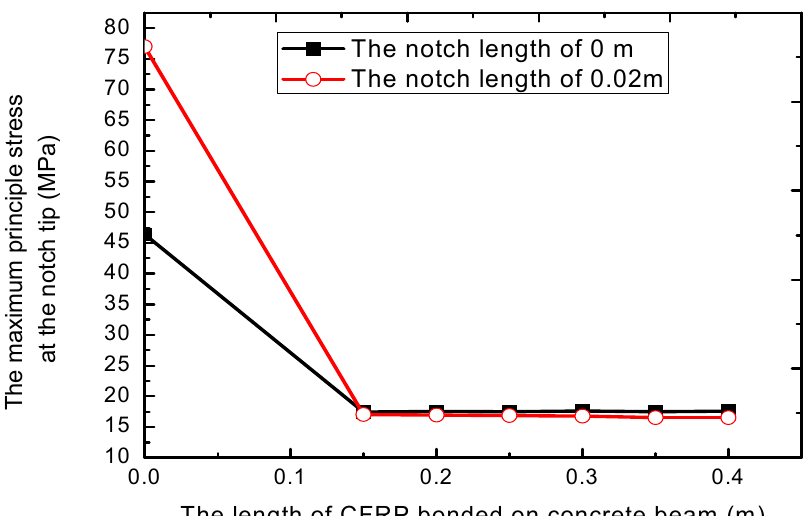
Figure 10. The plot of maximum principle stress against the length of